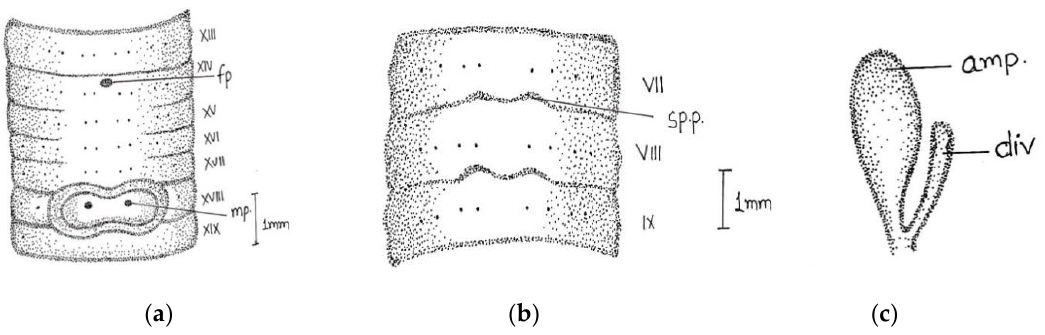
Figure 4. Camera lucida illustration of Megascolex filiciseta ( a ) genital region; ( b ) spermathecal pore;